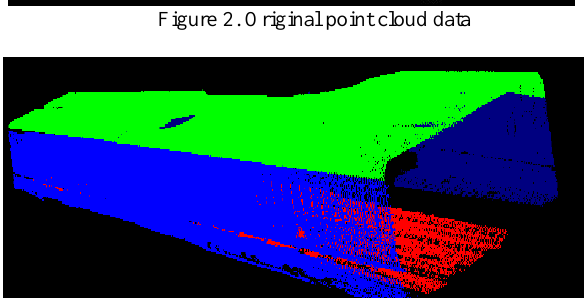
Figure 3. Point cloud data processed by clustering and